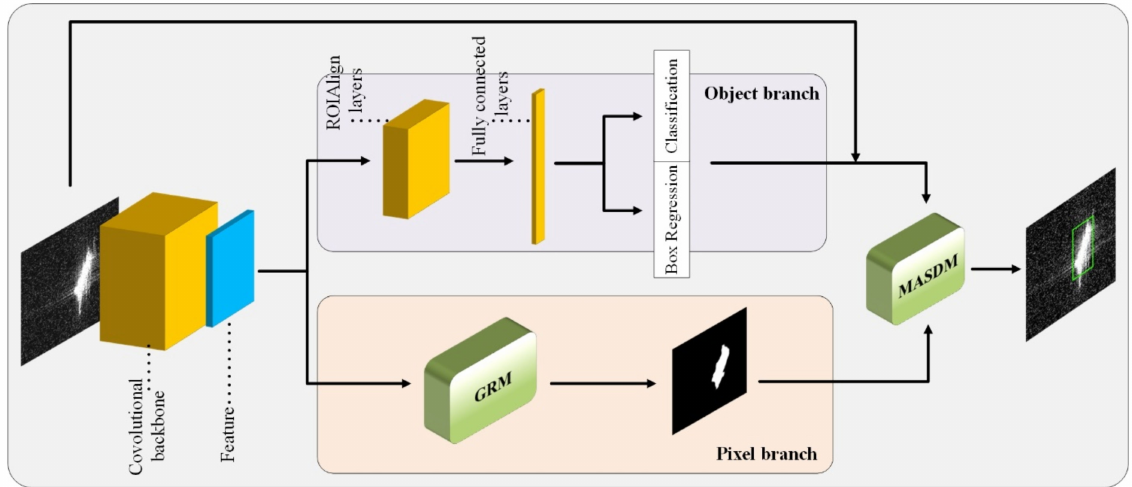
Figure 2. Architecture of ISASDNet, which has a two-branch structure, i.e., an object branch and a pixel branch. The backbone network is a combination of ResNet, FPN, and RPN. The object branch can obtain rough object detection results. The pixel branch is based on global relational inference and can obtain the instance segmentation results. MASDM can fuse the results from these two branches to obtain more accurate object detection